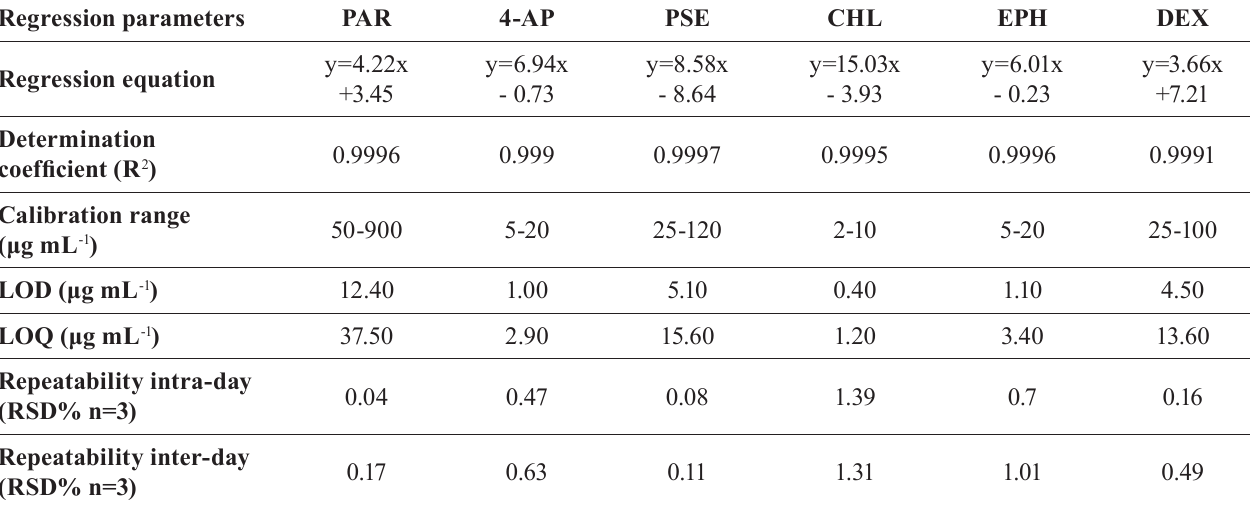
Table II - Results of regression parameters Regression parameters Regression